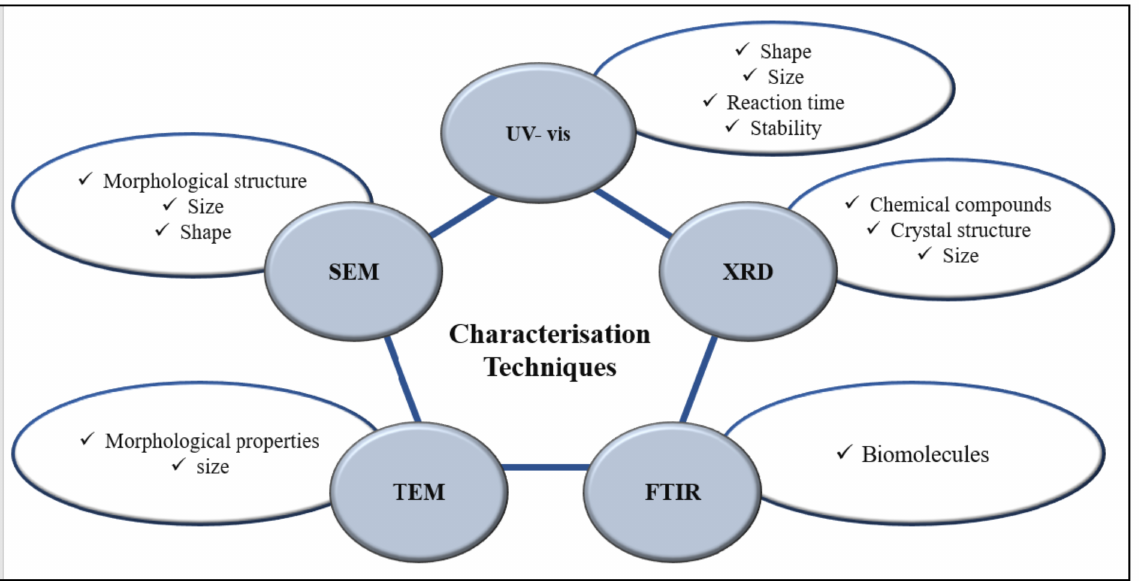
Figure 6. The most-used characterisation techniques (TEM, SEM, UV-vis, XRD, and FTIR) to investigate different features (size, shape, diameter) of MNPs derived from Eucalyptus